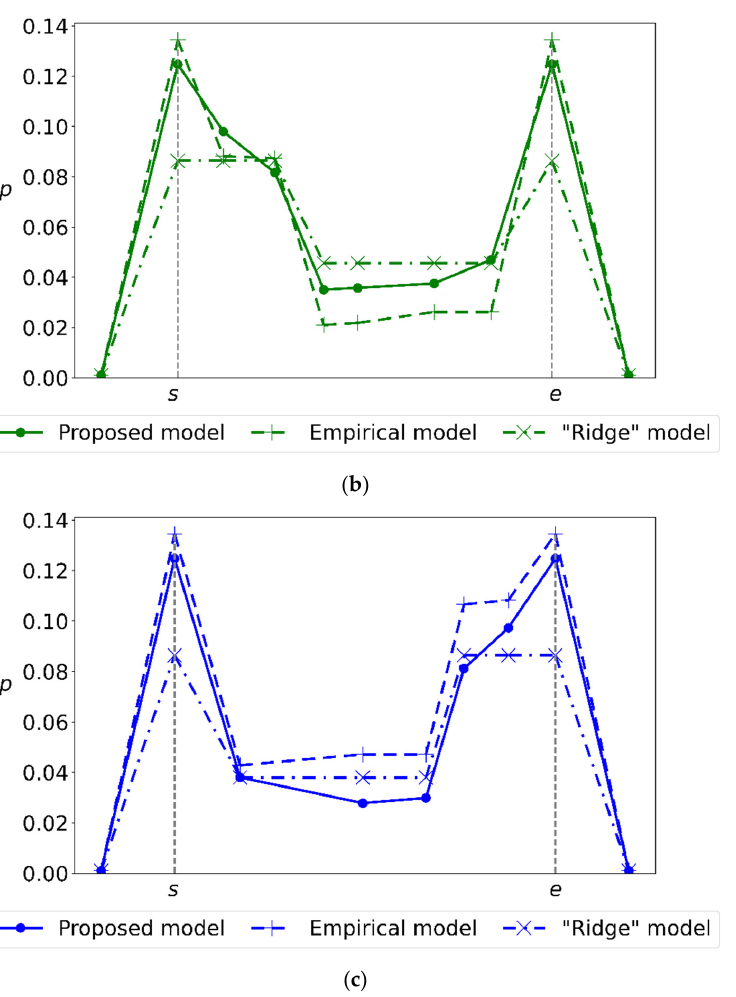
Figure 11. The proposed model, “ridge” model and empirical model for each path: ( a ) red line, ( b ) green line and ( c ) blue